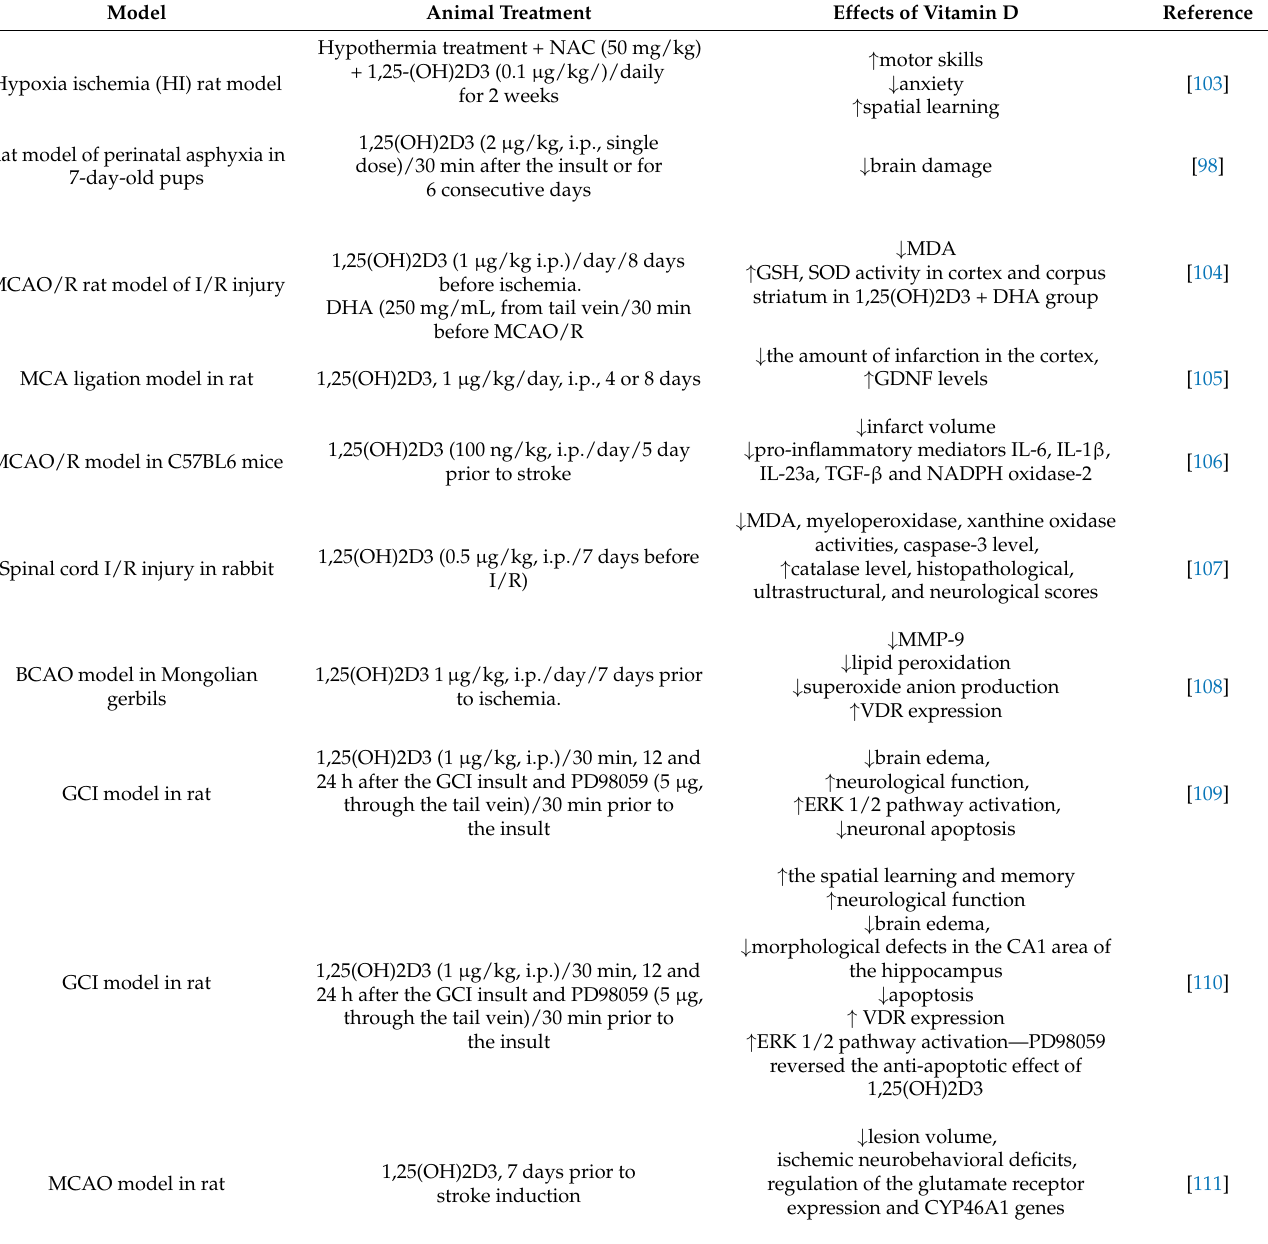
Table 2. Effects of vitamin D in experimental stroke models—in vivo